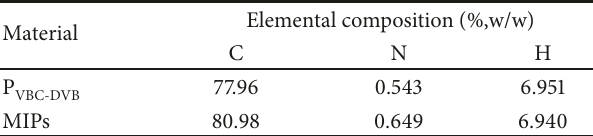
Table 1: Elemental analysis of imprinted materials. Material